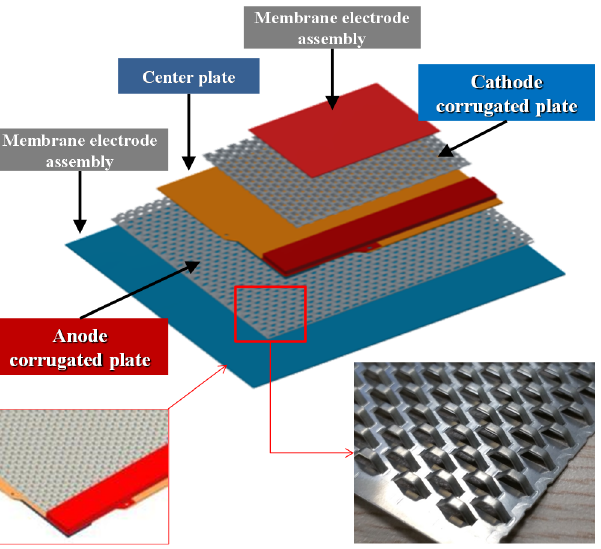
Figure 1. Illustration of a unit cell package consisting of membrane electrode assemblies, corrugated plates, and a center plate.